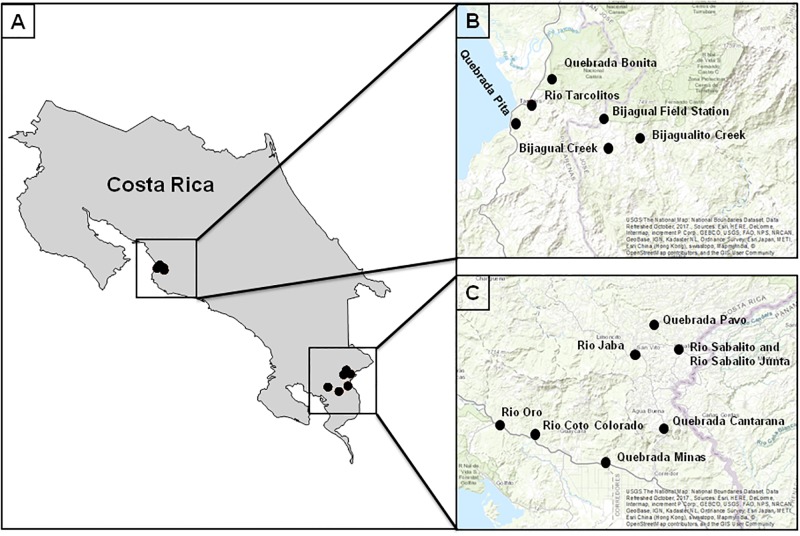
Sampling localities for S. sordida in Costa Rica.(A) Variation in latitude among sampled populations. (B) Magnified view of northern latitude populations and (C) southern latitude populations. Population elevations and total individuals captured: Bijagual Field Station (449m, n = 10), Bijagual Creek (445m, n = 12), Bijagualito Creek (446m, n = 10), Quebrada Bonita (59m, n = 7), Quebrada Pita (18m, n = 10), Rio Tarcolitos (22m, n = 10), Quebrada Cantarrana (1,053m, n = 7), Rio Jaba (964m, n = 10), Rio Sabalito/Rio Sabalito-Juntas (899m/784m, n = 15), Quebrada Pavo (795m, n = 1), Rio Coto Colorado (76m, n = 16), Quebrada Minas (30m, n = 5), Rio Oro (82m, n = 10).